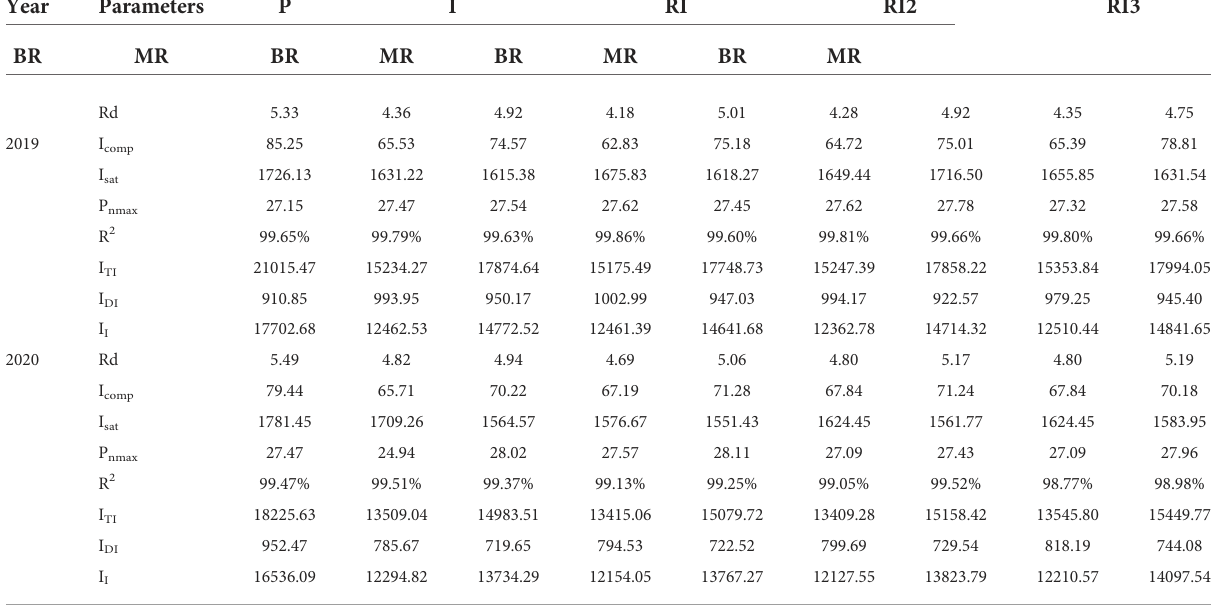
TABLE 1 The Ye model light response curve and light interception of